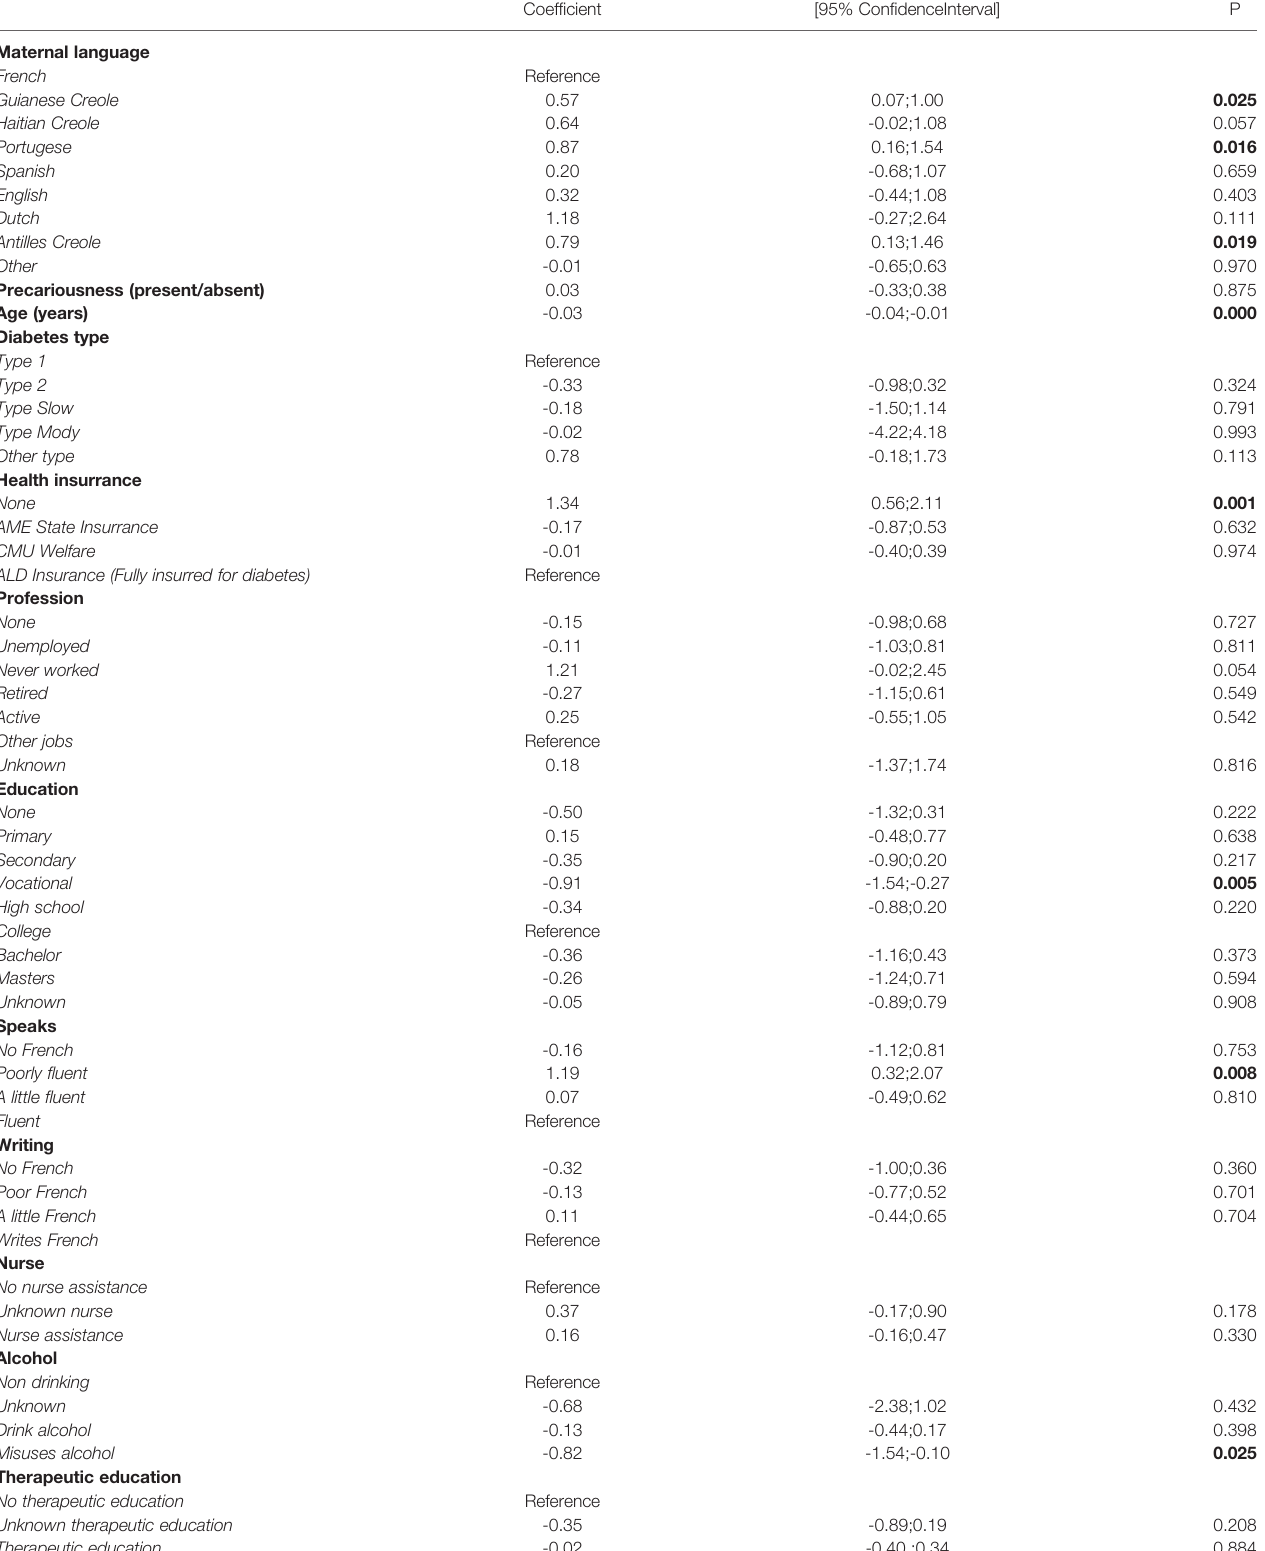
TABLE 4 | Multiple linear regression model of glycated hemoglobin concentration and demographic and socioeconomic independent variables.